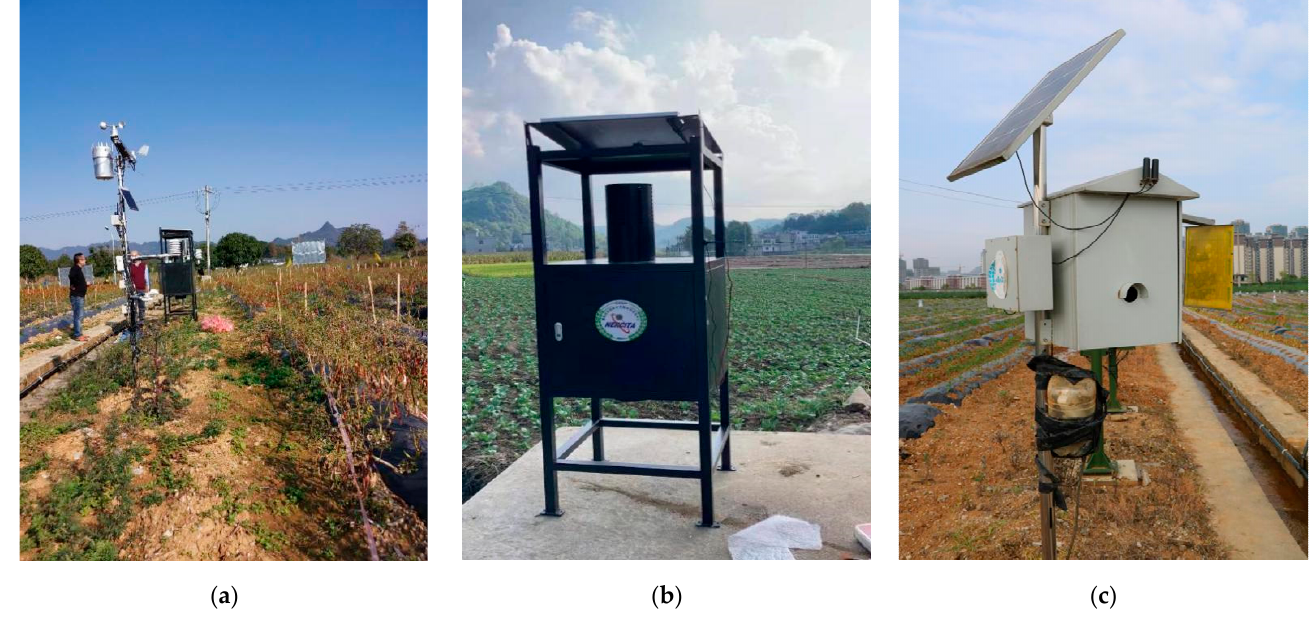
Figure 1. Hot pepper disease and pest monitoring equipment in Guizhou. ( a ) weather station; ( b ) pathogen monitoring equipment; and ( c ) pest monitoring equipment.